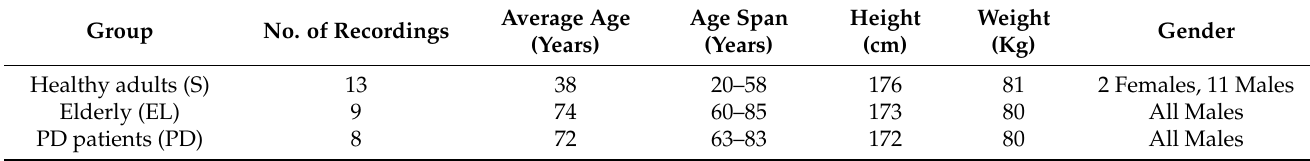
Table 1. The details of Smart-Insole’s Dataset participants.